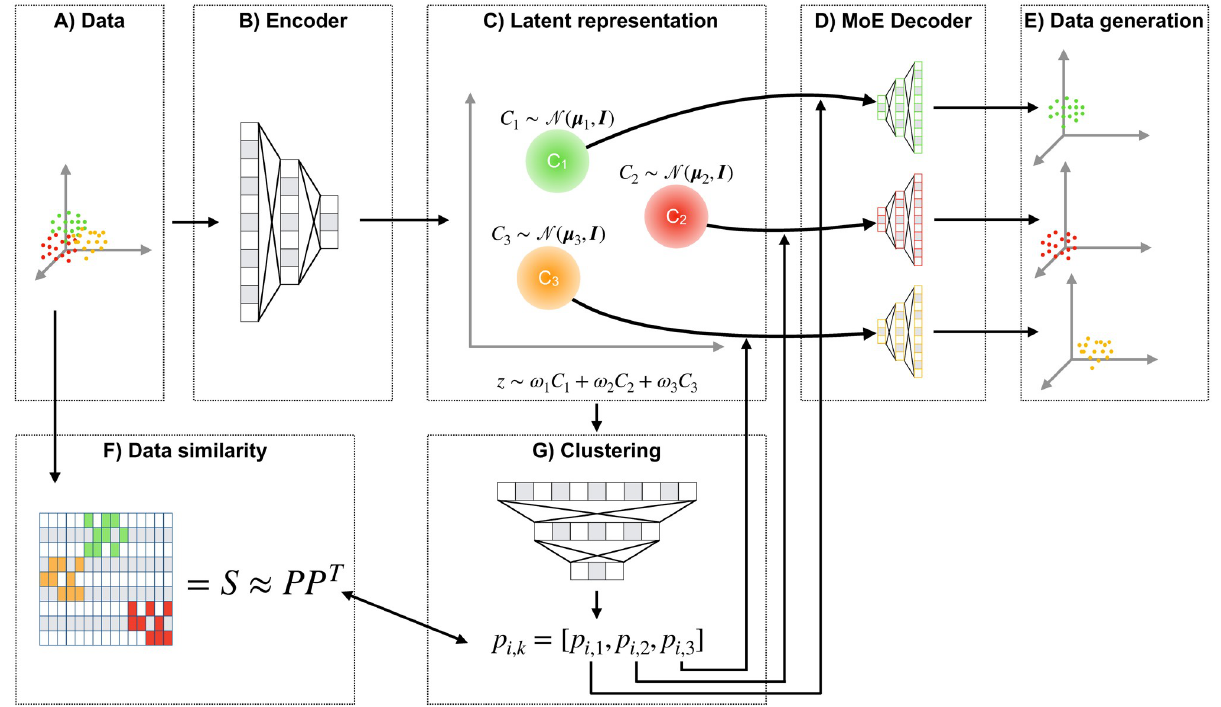
Fig 1. Schematic overview of MoE-Sim-VAE. Data (in panel A) gets encoded via an encoder network (B) into a latent representation (C) which is trained to be a mixture of standard Gaussians. Via a clustering network (G), which is trained to reconstruct a user-defined similarity matrix (F), the encoded samples get assigned to the data mode-specific decoder subnetwork (which we call experts) in the MoE Decoder (D). The experts reconstruct the original input data and can be used for data generation when sampling from the variational distribution (E).